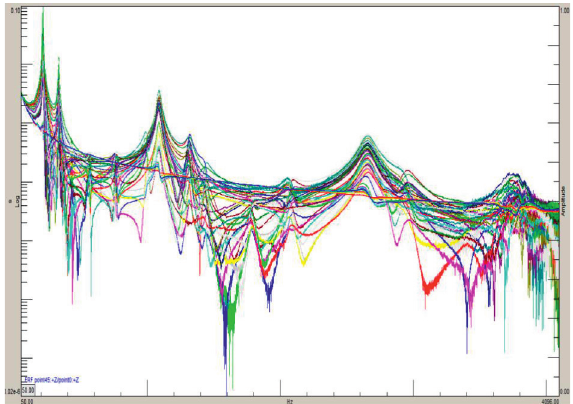
Figure 8: Experimental frequency response function base exci- tation vs